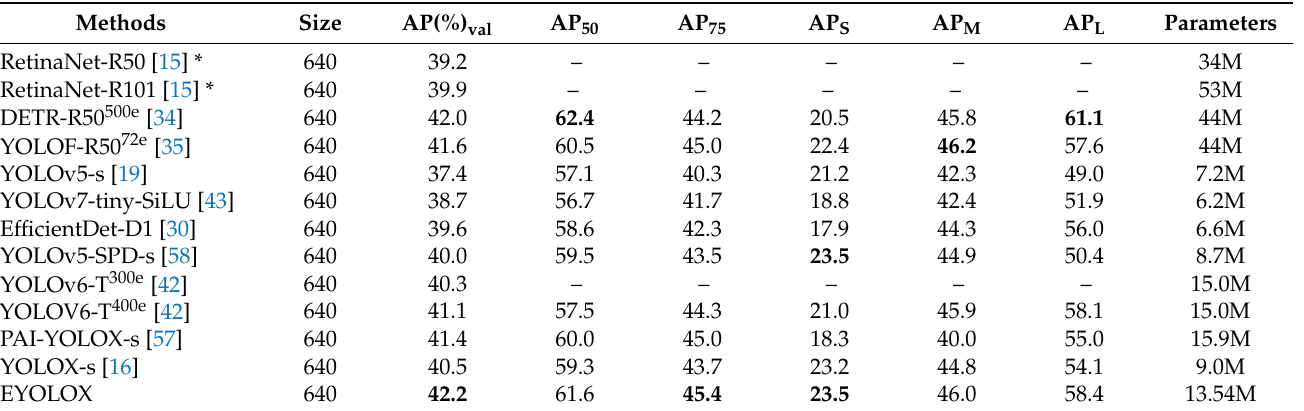
Table 4. Comparison of the accuracy of different object detectors on COCO-2017 val. The methods marked with “*” are the results reproduced in other papers. Without the associated annotations, all our results are derived under 300 epochs.